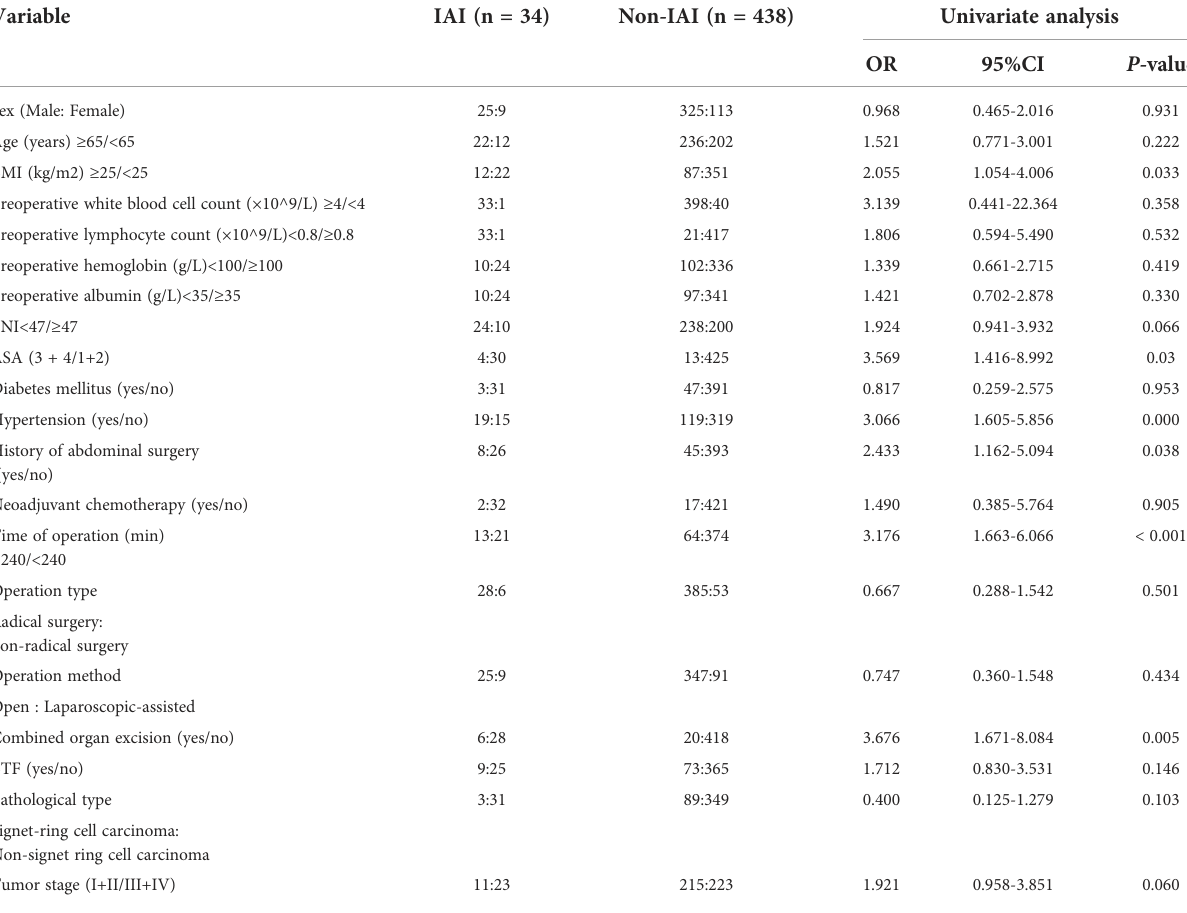
TABLE 3 Univariate analysis of possible predictors of risk of IAI based on training